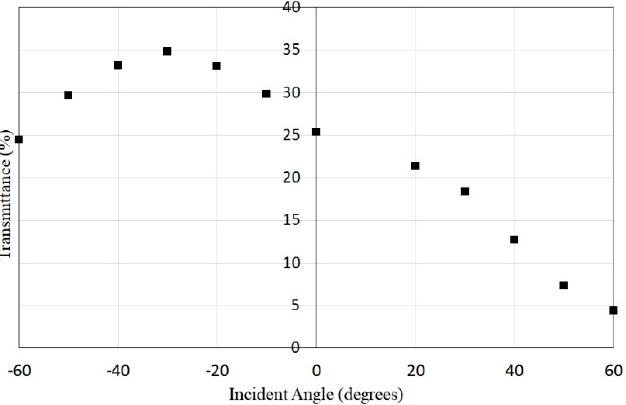
Figure 12. Transmittance dependence on the incident angle for the two-layer LCDs of 40° pretilt angle. The concentration of NKX-4010 (Hayashibara Ltd., Japan) dye was 1 wt.%.